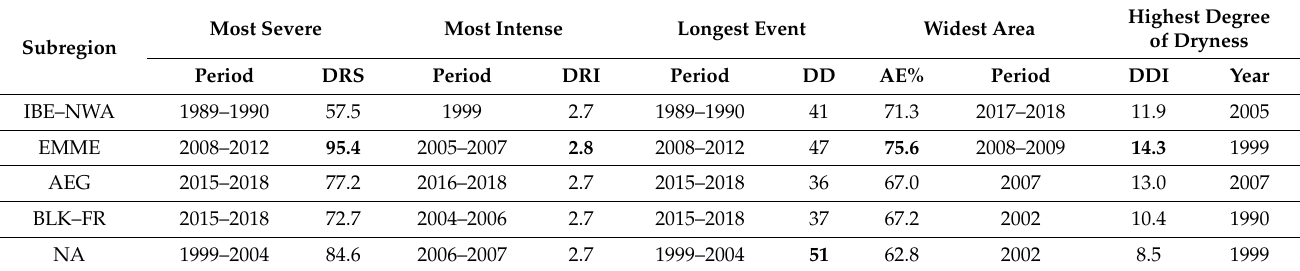
Table 5. The top drought events (most severe, most intense, longest, widest dry events) and the highest degree of dryness in each subregion according to DXI-12 during